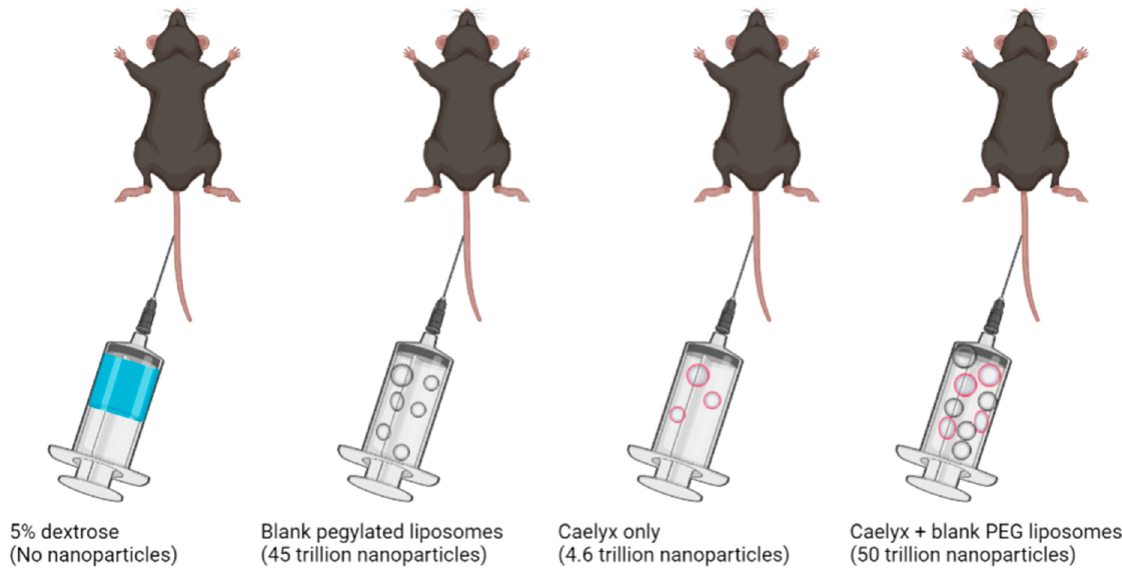
Figure 2. Scaled dosing of nanoparticles according to threshold required to overwhelm Kupffer cells. Adapted from [92].